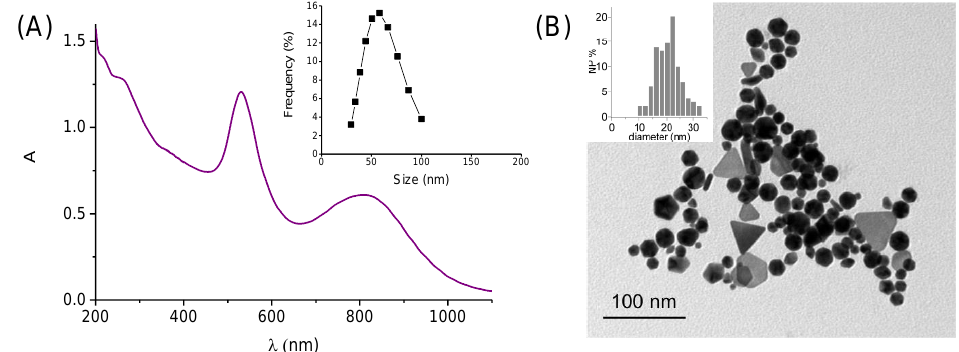
Figure 2. ( A ) Absorption spectrum of an aqueous dispersion of Au@PolyCD. The inset shows the size distribution of Au@PolyCD measured by DLS. ( B ) Representative TEM image of Au@PolyCD. The inset shows the size distribution of the almost-spherical NPs.